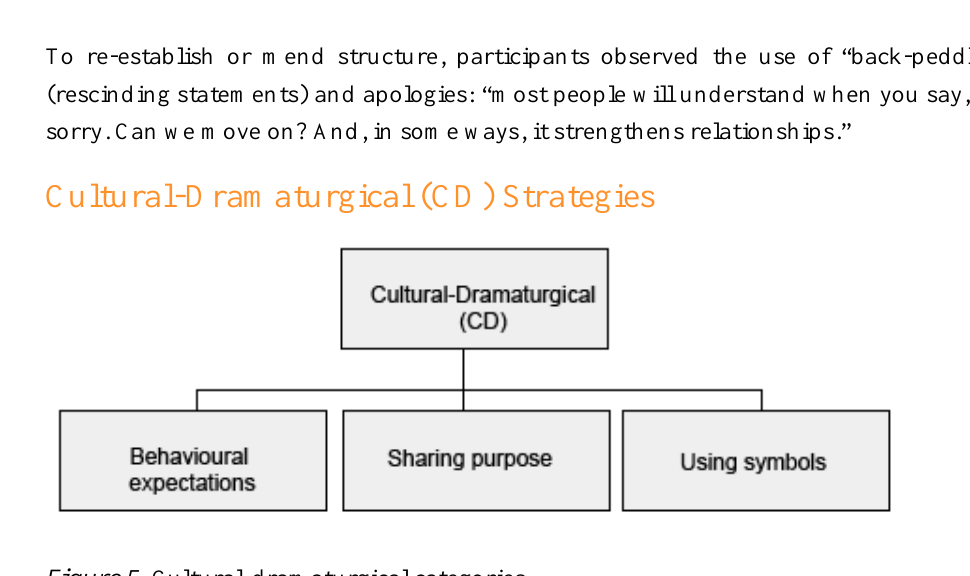
Figure 5 . Cultural-dramaturgical categories.